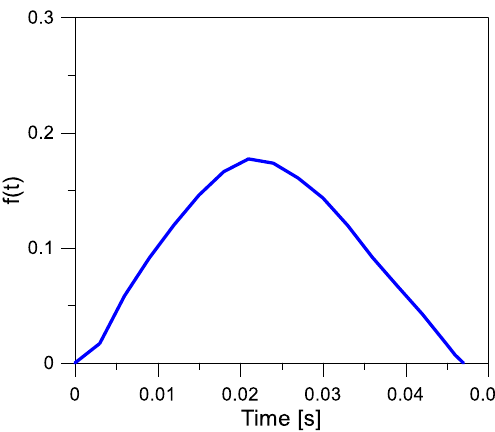
Figure 3. Typical trend for the time factor f (t).